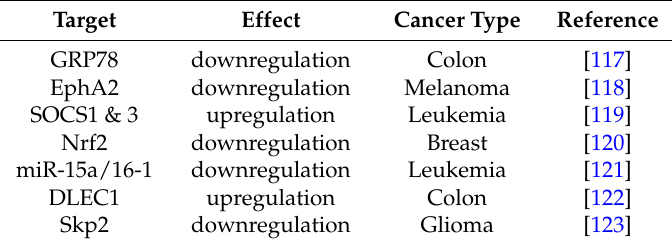
Table 1. Antiproliferative targets for